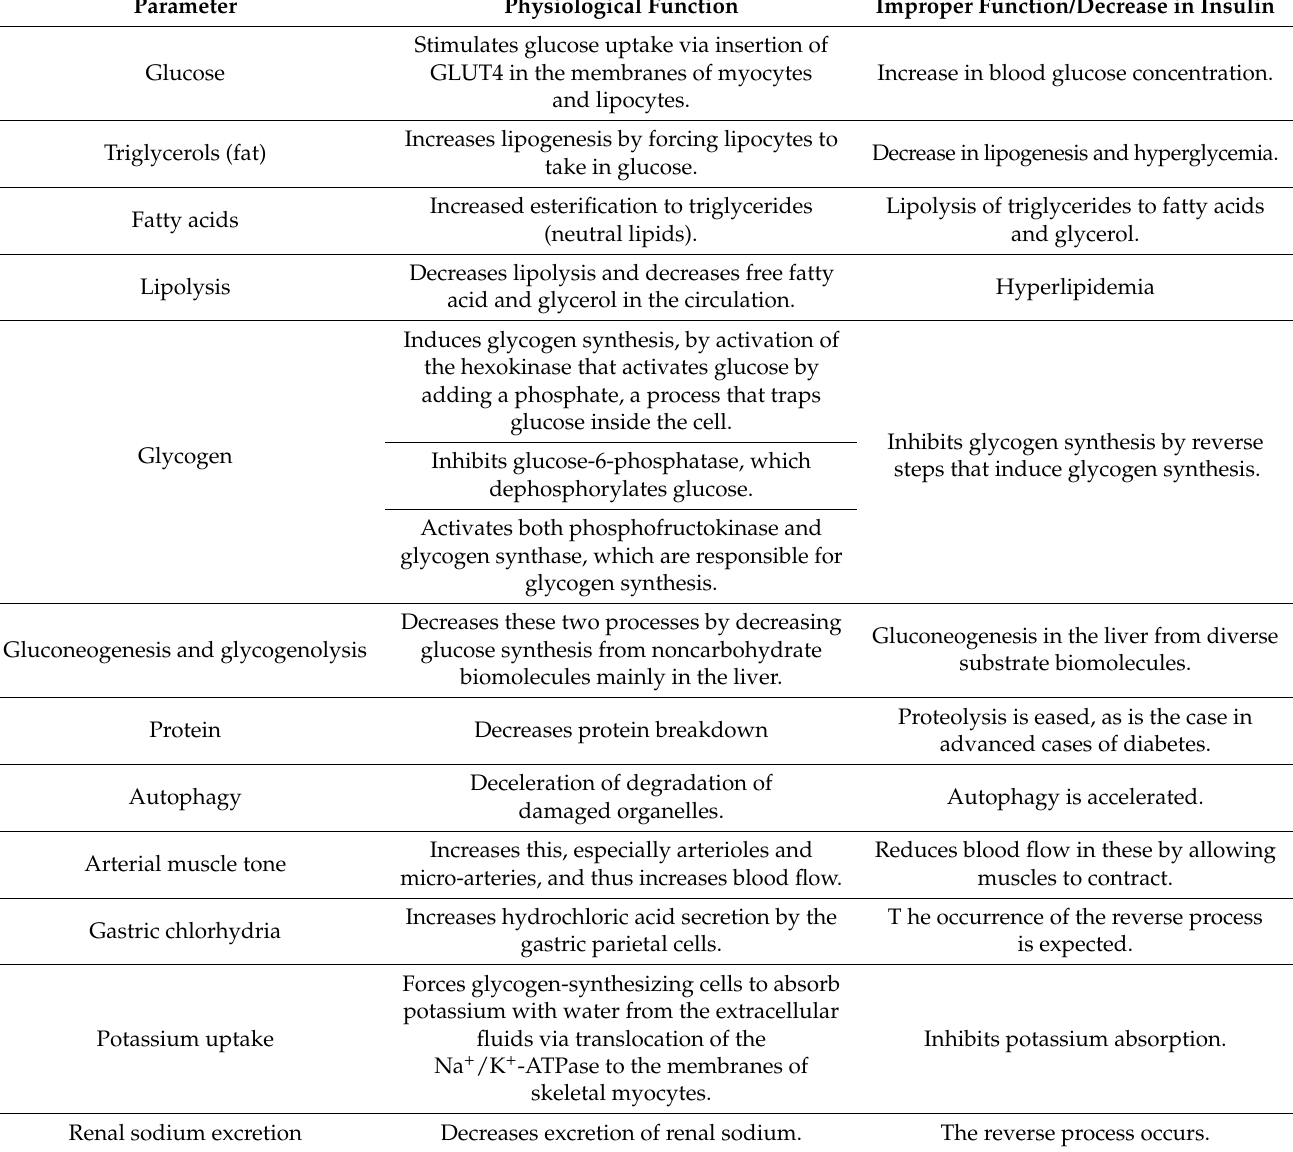
Table 2. Direct and indirect metabolic effects of